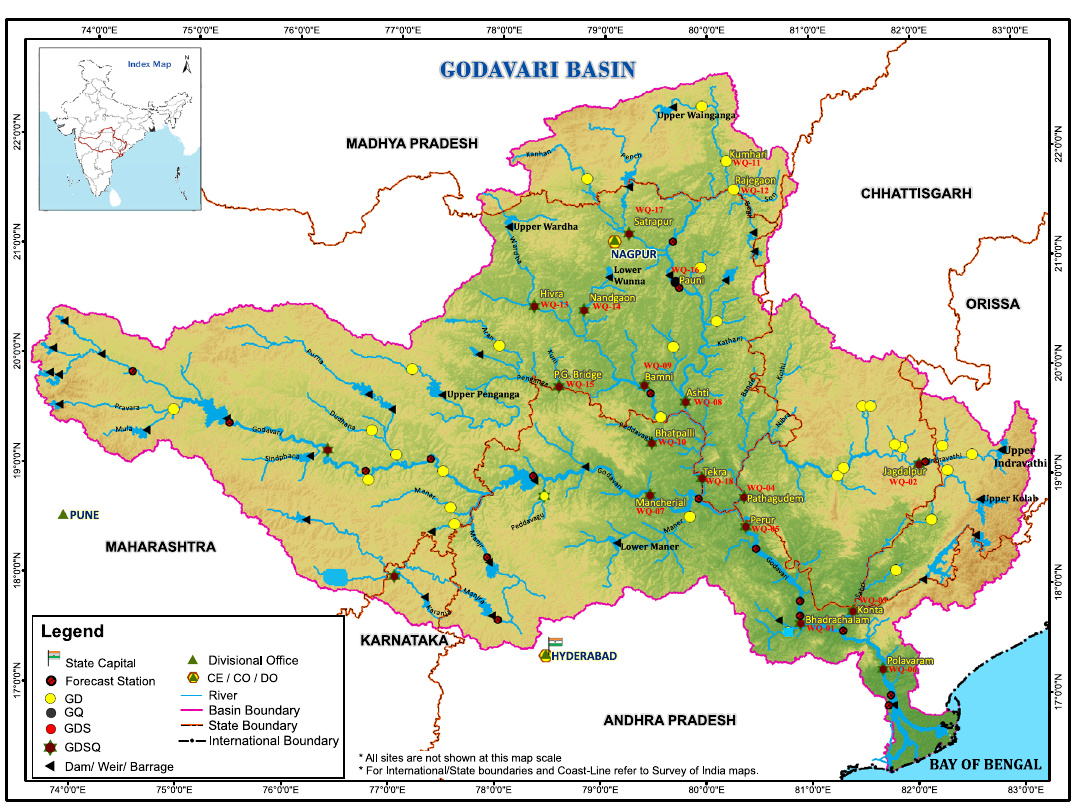
Fig. 1 Godavari basin Table 2 Water quality stations on river Godavari and its tributaries Sr.